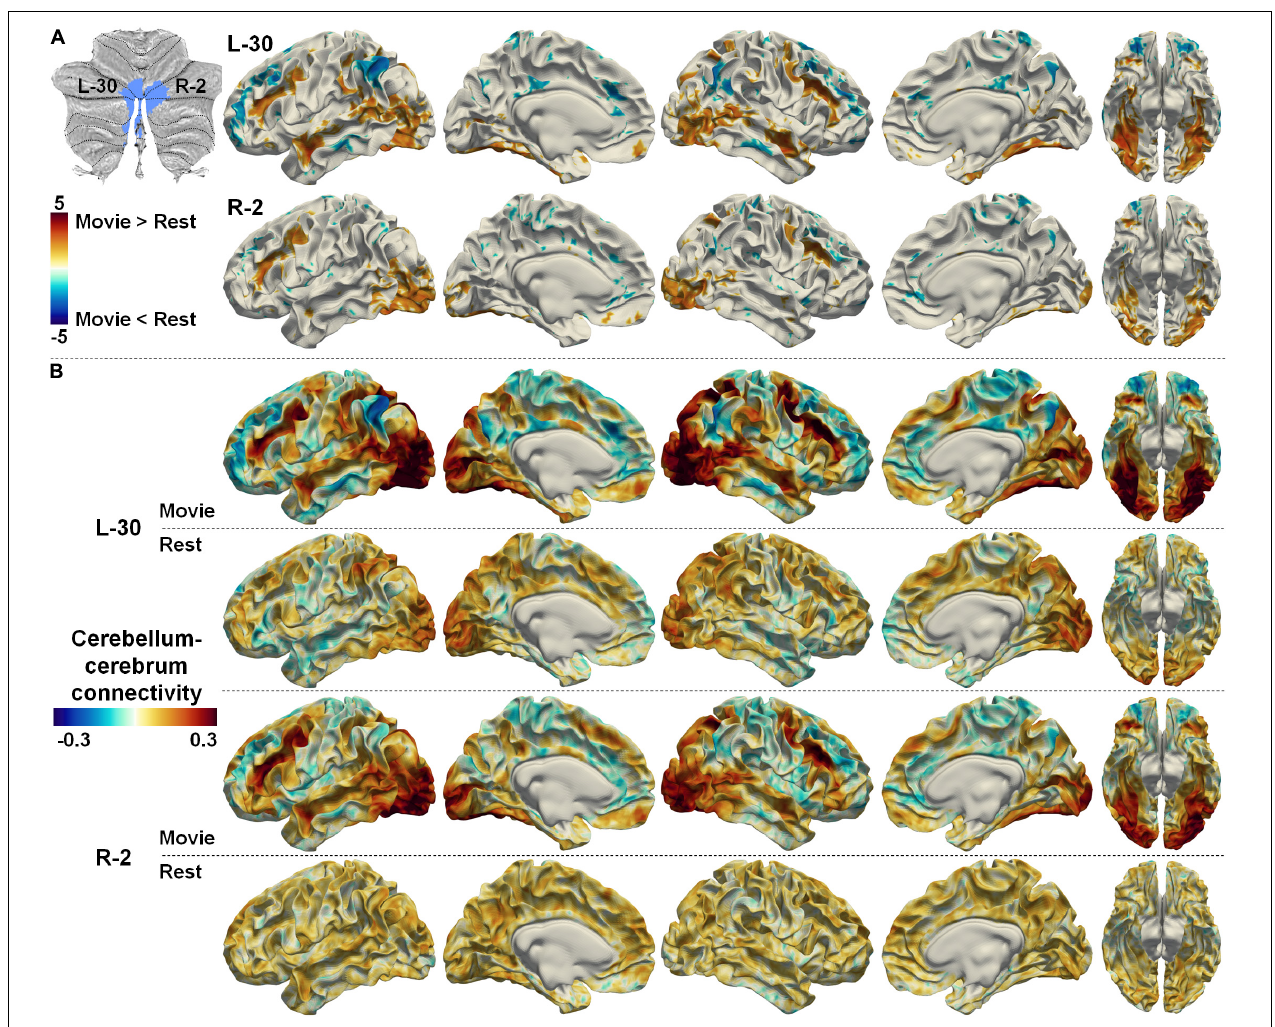
FIGURE 7 | (A) The difference between cerebellum–cerebrum connectivities in nfMRI and rsfMRI for two symmetrical regions (L-30 and R-2, related to visual) in the Movie 64 parcellation. (B) The strength of cerebellum–cerebrum connectivities for the two regions in nfMRI and